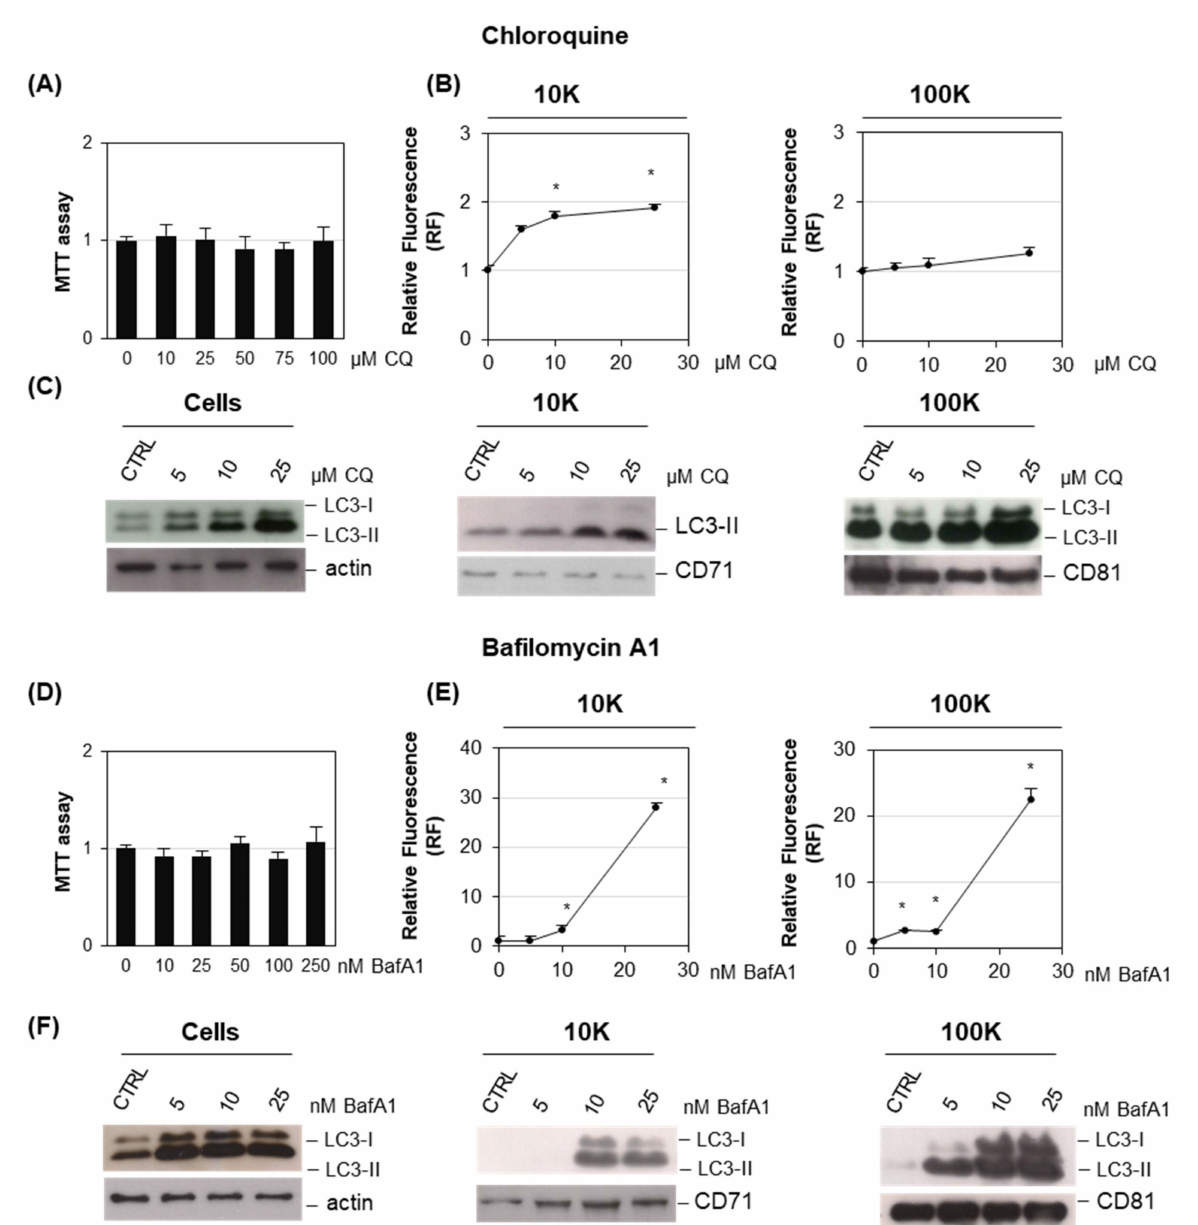
Figure 7. Analysis of EVs release by HEK-mCherry-CD63 upon chloroquine (CQ) and bafilomycin A1 (BafA1) treat- ment . ( A , D ) Viability of HEK-mCherry-CD63 cells determined by MTT assay. Data are the mean ± SE of three independent experiments, each performed in triplicate. ( B , E ) Fluorescence analysis of EVs. EVs were obtained by centrifugation at 10,000 × g (10K fraction) and 100,000 × g (100K fraction). Pellets were resuspended in 100 µ L PBS, transferred on a 96-well microplate and assayed for fluorescence at 580 nm ex/620 nm em. Values are the mean ± S.E. of at least three experiments, each one in duplicate. * p < 0.05,with respect to vehicle-treated cells as control (set 1). ( C , F ) Characterization of EVs associated markers. Cell extracts (30 µ g) and EV preparations (3 µ g) were separated by SDS-PAGE, electrotransferred, and probed with the indicated